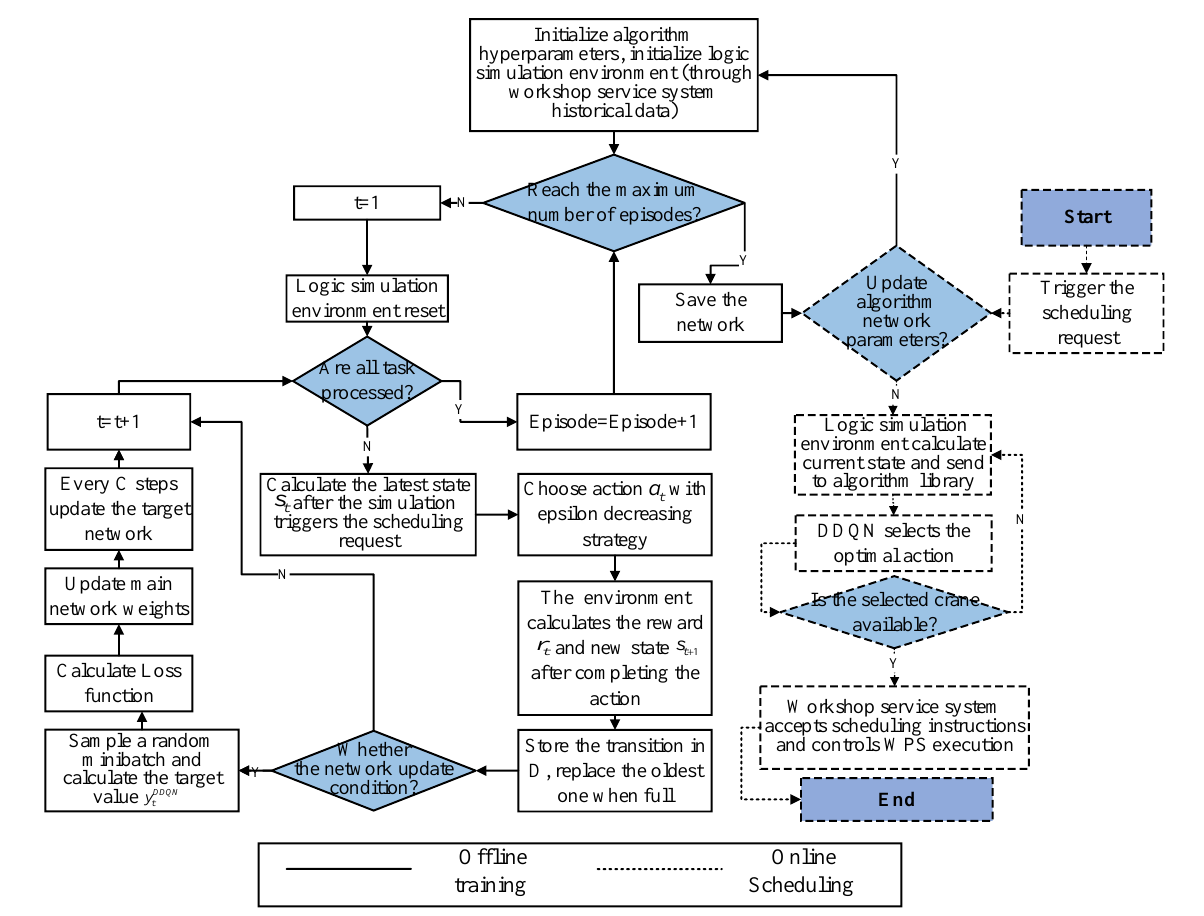
Figure 3. Crane scheduling under DRL-DT.